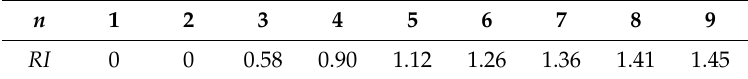
Table 3. Average random consistency index